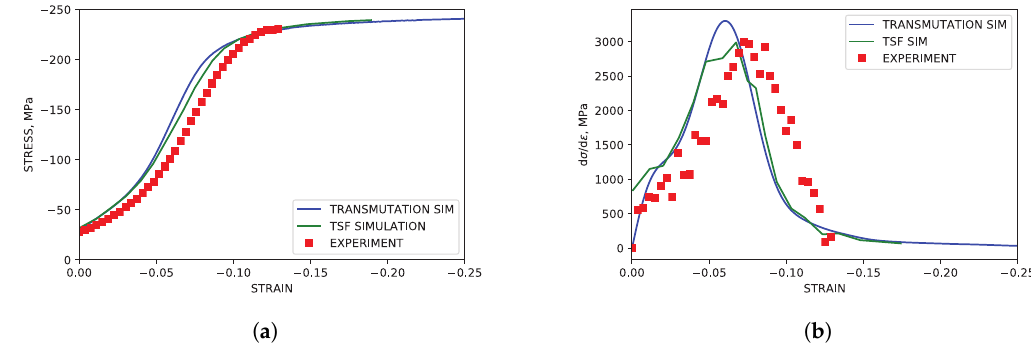
Figure 6. Simulated and experimental mechanical response under IPC compression. ( a ) Stress-strain. ( b ) Hardening rate vs. strain.